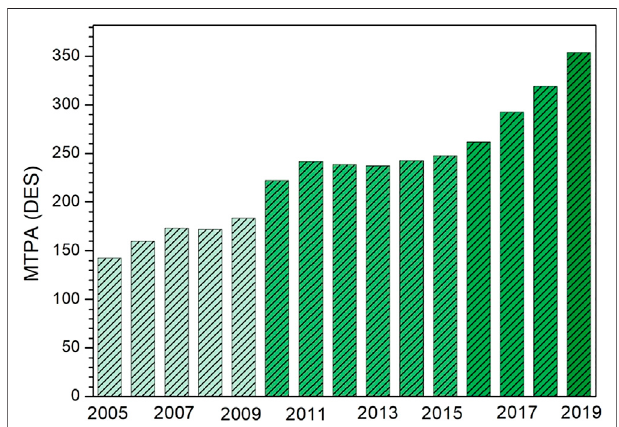
FIGURE 1 | LNG trade volume trend from 2005 to 2019 (Shell LNG outlook, 2019).